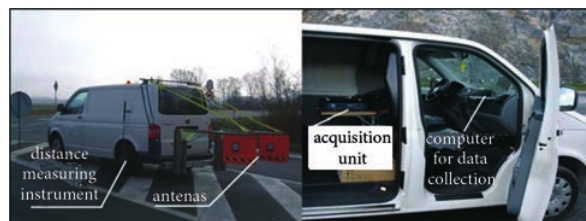
Fig. 1. Department of transportation’s GPR equipment mounted on vehicle